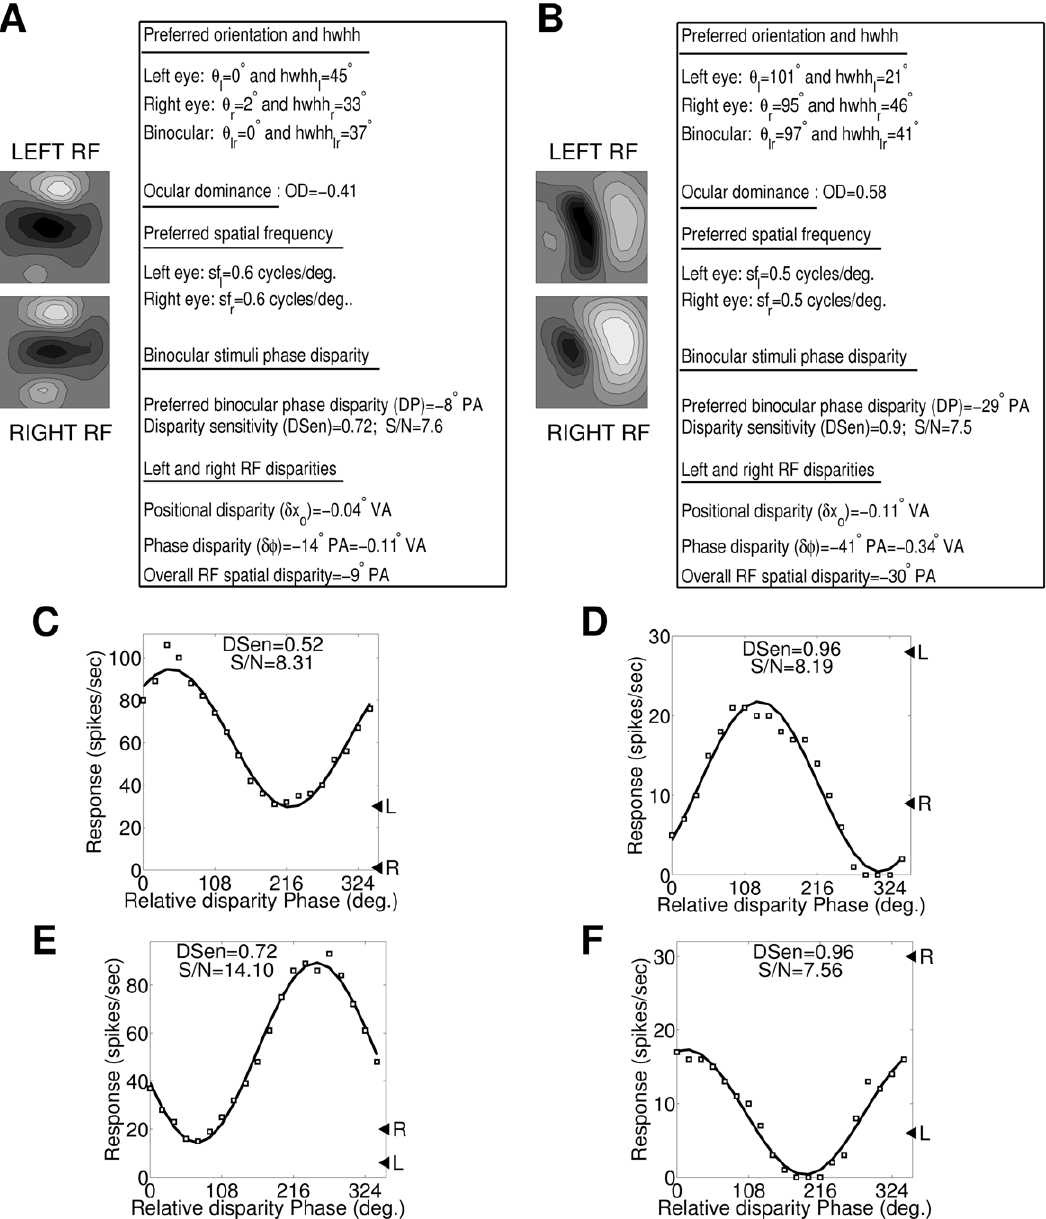
Figure 3. Binocular interaction in almost monocularly driven simple cells shows robust disparity selectivity. (A, B) Two sample cortical cells from our model cortex with left and right RFs along with their response characteristics and disparity values tabulated in table. (C, D) Phase disparity tuning curves for two sample cortical cells from our model. For both these cells, left monocular response (shown as b L) dominates over the right monocular response (shown as b R) with OD values of -1 and -0.83 respectively. The OD values closer to -1 categorize them as monocular left eye driven cells. These cells show robust binocular interaction with DSen (S/N) values of 0.52 (8.31) and 0.96 (8.19) respectively. The nature of binocular interaction is synergistic for the first cell (Figure 3C) and suppressive for the second cell (Figure 3D). (E, F) Phase disparity tuning curves for two sample monocular cortical cells with OD values close to + 1. For both these cells, right monocular response (shown as b R) dominates over the left monocular response (shown as b L) with OD values of 0.92 and 0.84 respectively. These cells show robust binocular interaction with DSen (S/N) values of 0.72 (14.1) and 0.96 (7.56) respectively. The nature of binocular interaction is synergistic for the first cell (Figure 3E) and suppressive for the second cell (Figure